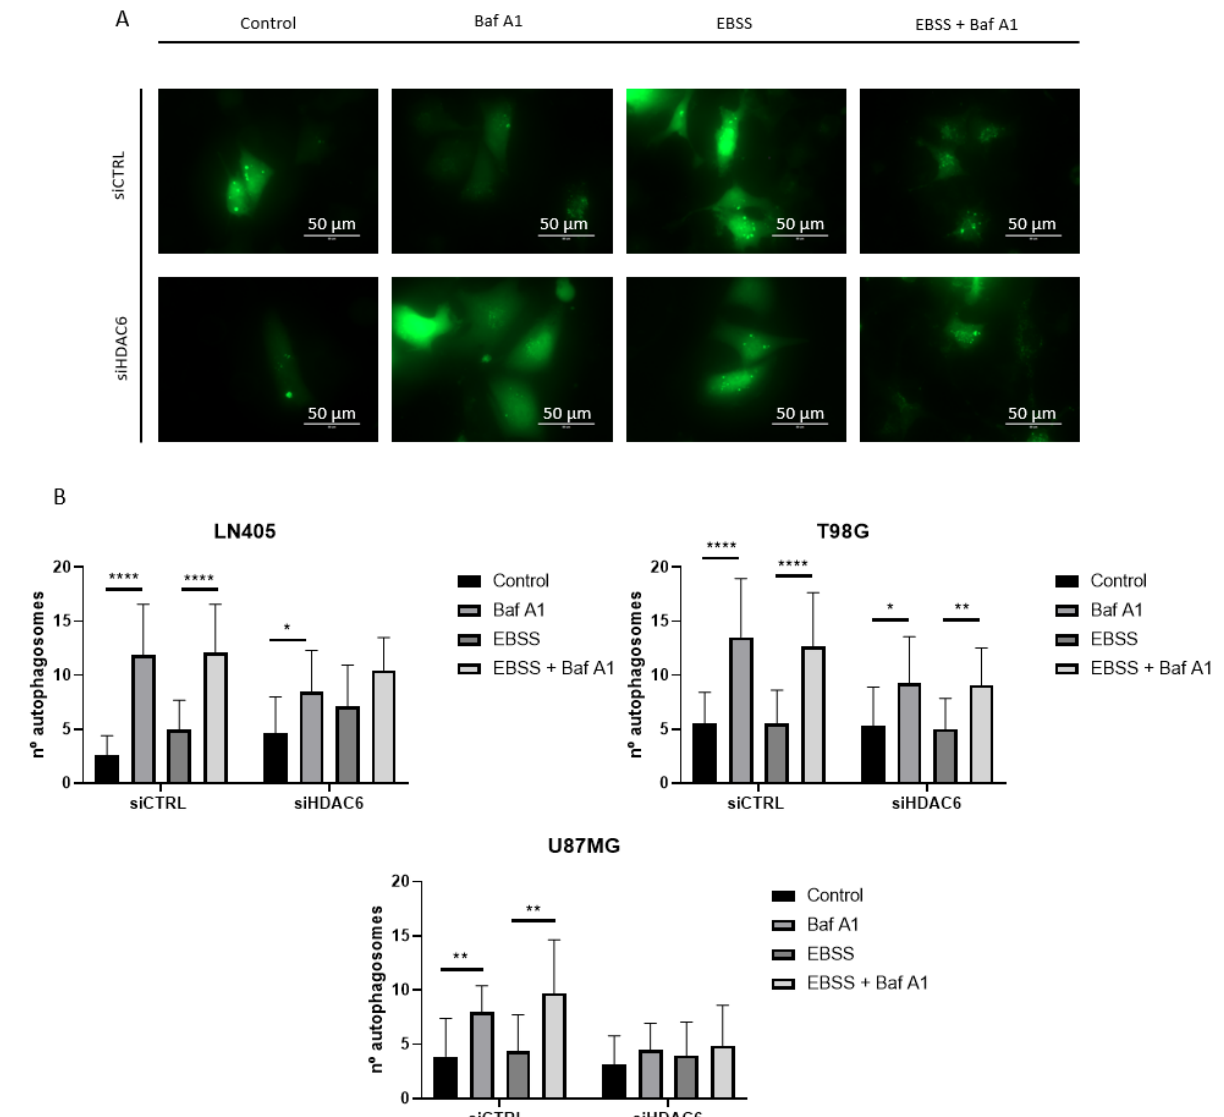
Figure 11. HDAC6 silencing decreases the number of autophagosomes per cell. ( A ) Representative image of a cell with autophagosomes after siRNAs treatment for 72 h and 100 nM Baf A1, EBSS, EBSS + Baf A1, or DMSO (as vehicle control) treatment for 6 h in LN405. Photographs were taken at 60 × . ( B ) Analysis of the number of autophagosomes per cell. Data are represented as mean ± SD (*) p < 0.05, (**) p < 0.01, (****) p < 0.0001.